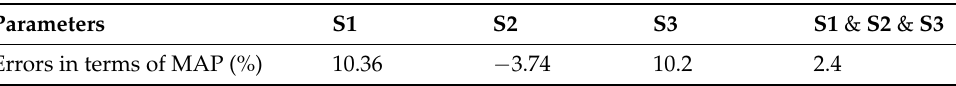
Table 3. Comparison of results obtained by inversion of sensor signals at different positions under the numerical model.